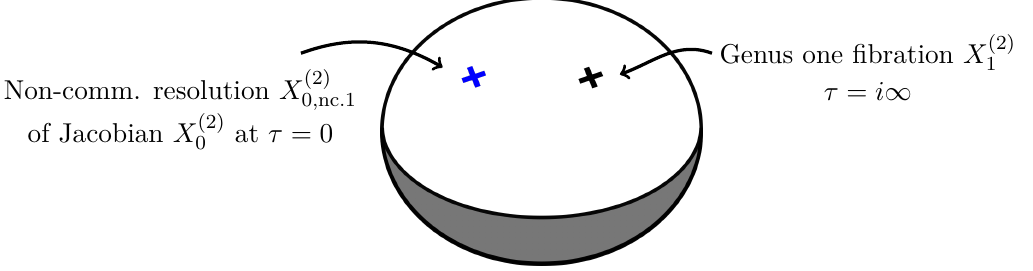
Figure 2 . The stringy Kähler moduli space of the generic genus one curve of degree 2 is the modular curve X (2) . For Calabi-Yau fibrations with 2 -sections, the large volume points in the Γ 1 τ = 0 correspond to the non-commutative resolution of the